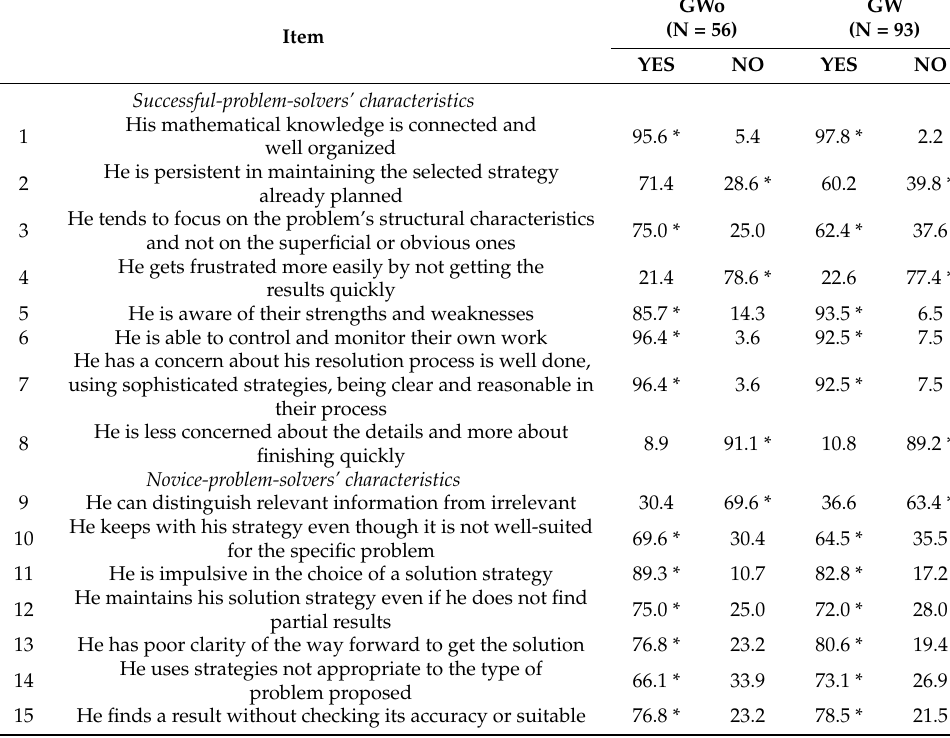
Table 1. Percentages of responses for knowledge of student as problem-solver.